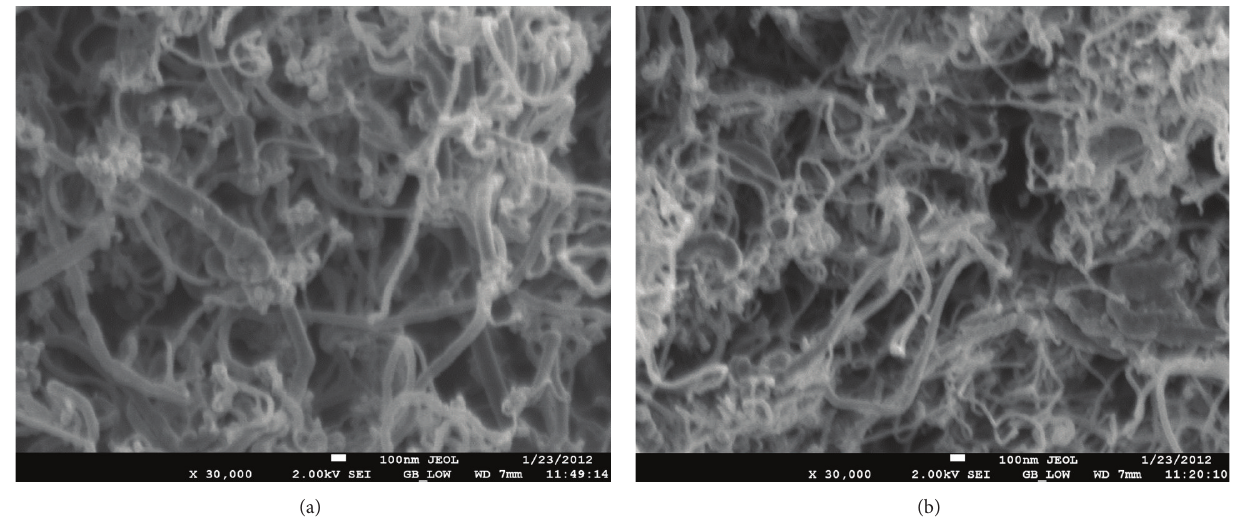
Figure 2: Scanning electron micrograph (SEM) of nanomaterial synthesized from (a) Fe/Co supported on magnesium oxide and (b) Fe/Co supported on calcium